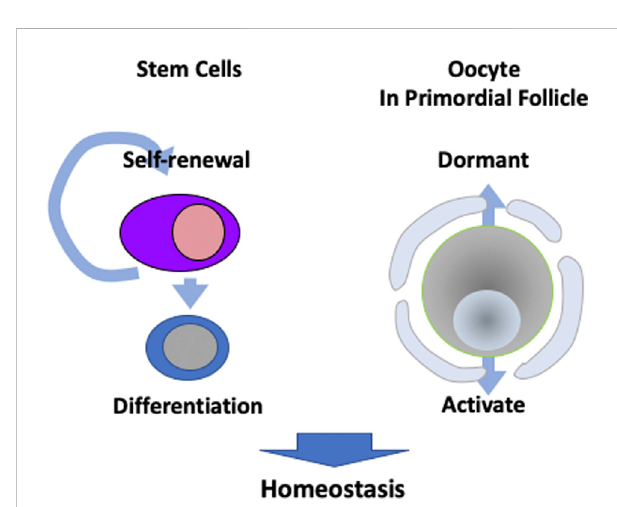
FIGURE 2 Different strategies to maintain homeostasis. Many tissues have stem cells that are capable of self-renewal and differentiation for metabolism. However, oocytes in primordial follicles are kept dormant, while a portion are activated in order to maintain sustainable ovulation